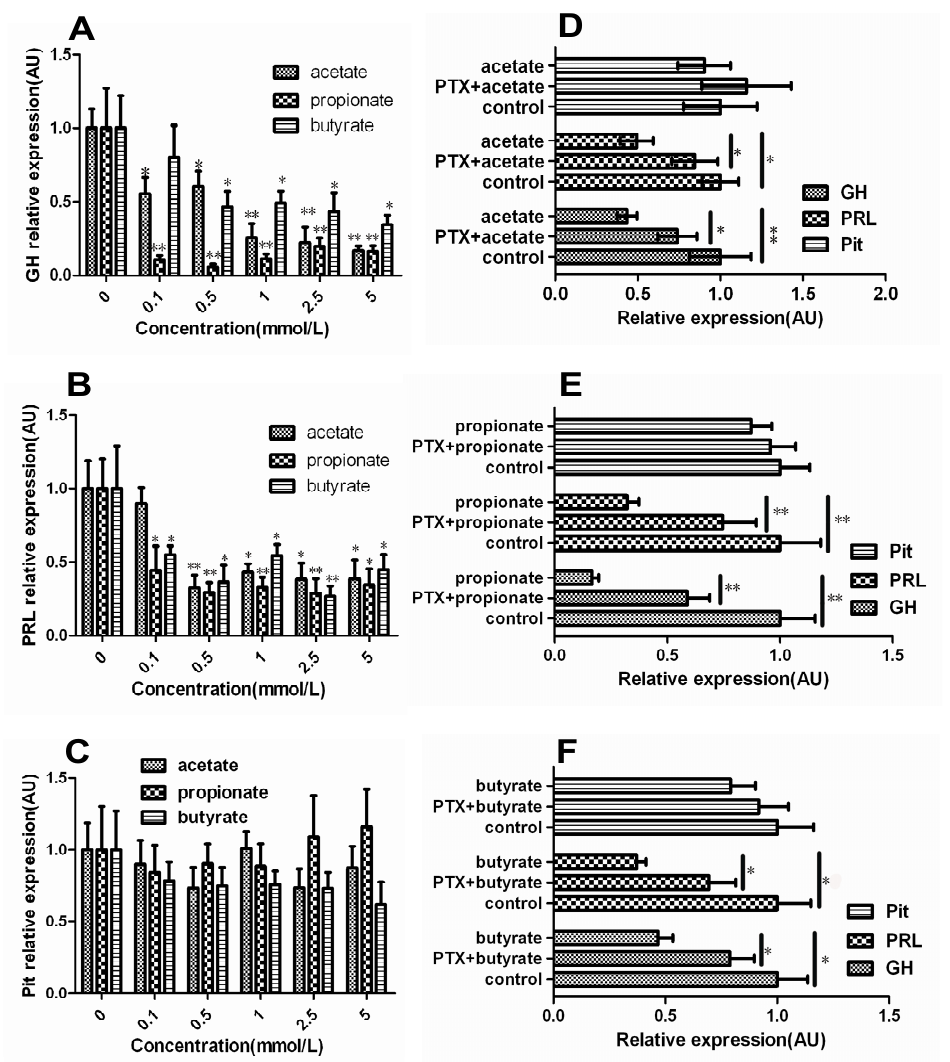
Figure 1. The effect of short-chain fatty acids (SCFAs) on the mRNA levels of GH , PRL and Pit-1 in dairy cow anterior pituitary cells (DCAPCs). DCAPCs were treated with 0, 0.1, 0.5, 1.0, 2.5 and 5.0 mmol/L acetate ( A ); propionate ( B ); and butyrate ( C ) for 24 h, respectively. The cells were also treated with or without prior PTX incubation (100 ng/L) for 2 h, and then stimulated with 1.0 mmol/L acetate ( D ); propionate ( E ); or butyrate ( F ) for 24 h, respectively. Each treatment replicated 12 times. * p < 0.05, ** p < 0.01 vs. the control